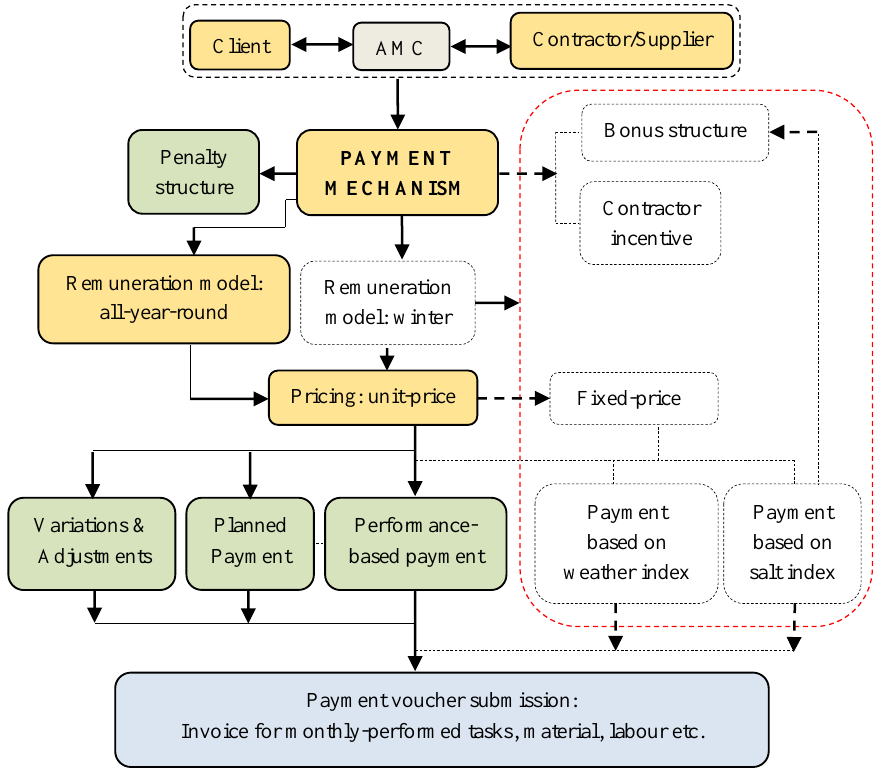
Figure 1 Flow chart of the Swedish payment mechanism for road